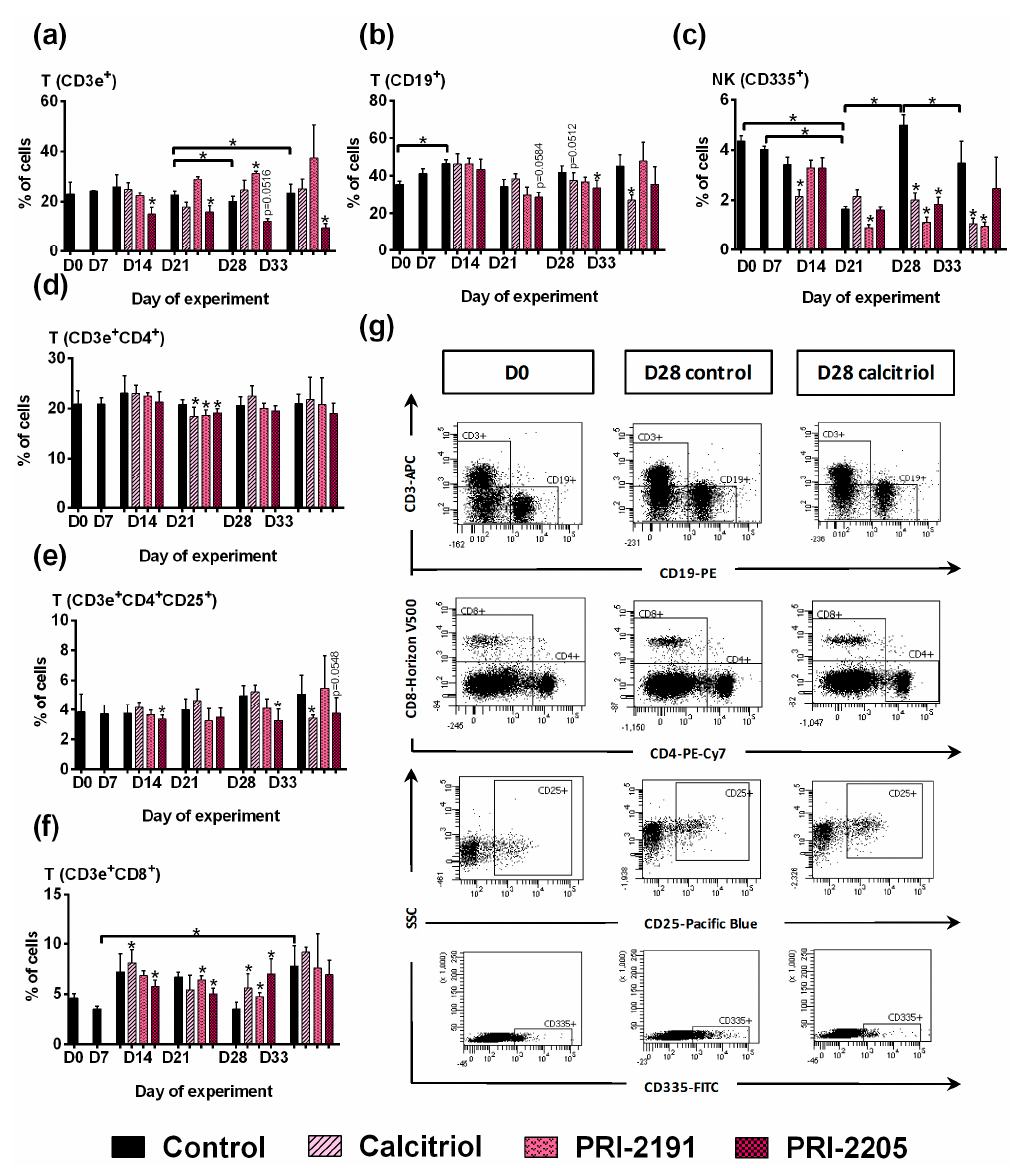
Figure 3. Spleen lymphocyte phenotypes in mice bearing 4T1 mammary gland tumors treated with calcitriol, PRI-2191, and PRI-2205. ( a ) T lymphocytes CD3e + ; ( b ) B lymphocytes CD19 + ; ( c ) NK cells CD335 + ; ( d ) TCD4 + lymphocytes; ( e ) TCD4 + CD25 + lymphocytes; ( f ) TCD8 + lymphocytes; ( g )